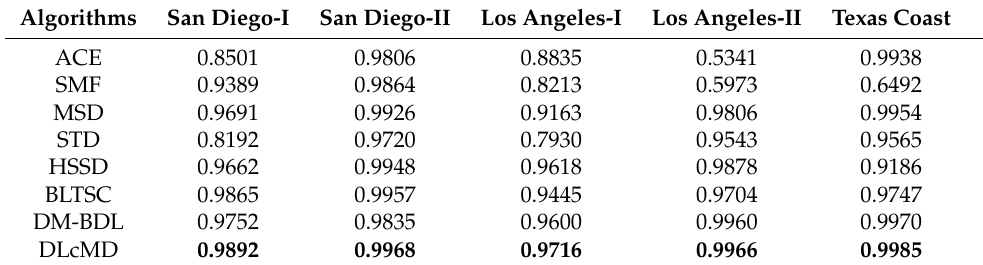
Table 1. AUC values of the five